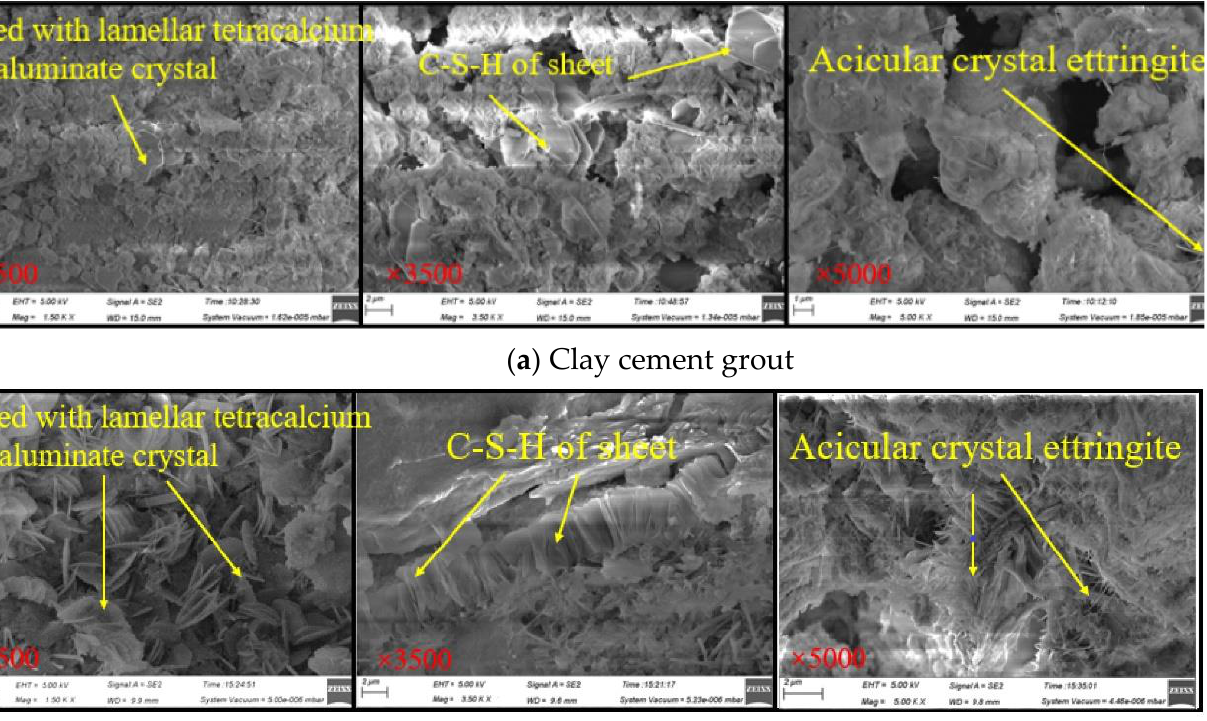
Figure 12. SEM images of hardened bodies.